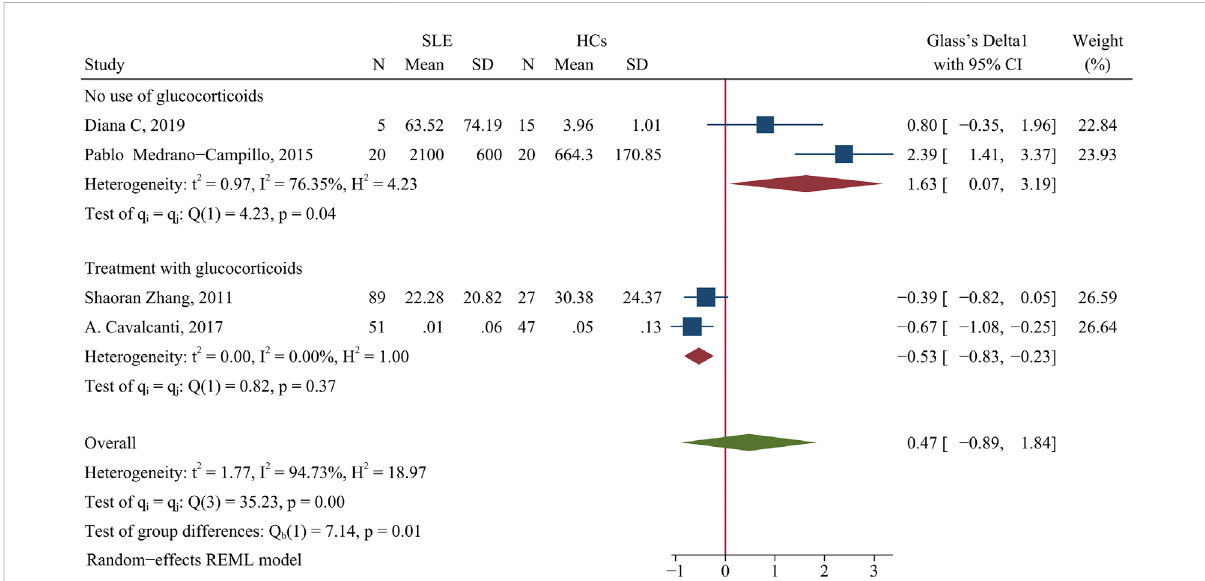
FIGURE 7 Forest plot of the concentration change of IL-2 in SLE patients compared with HCs. The overall results (bottom) show the meta-analysis of 4studies,andtheothertworesultsshowmeta-analysesoftwosubgroupsaccordingtoglucocorticoiduse.SLE,systemiclupuserythematosus;HCs, healthy controls.